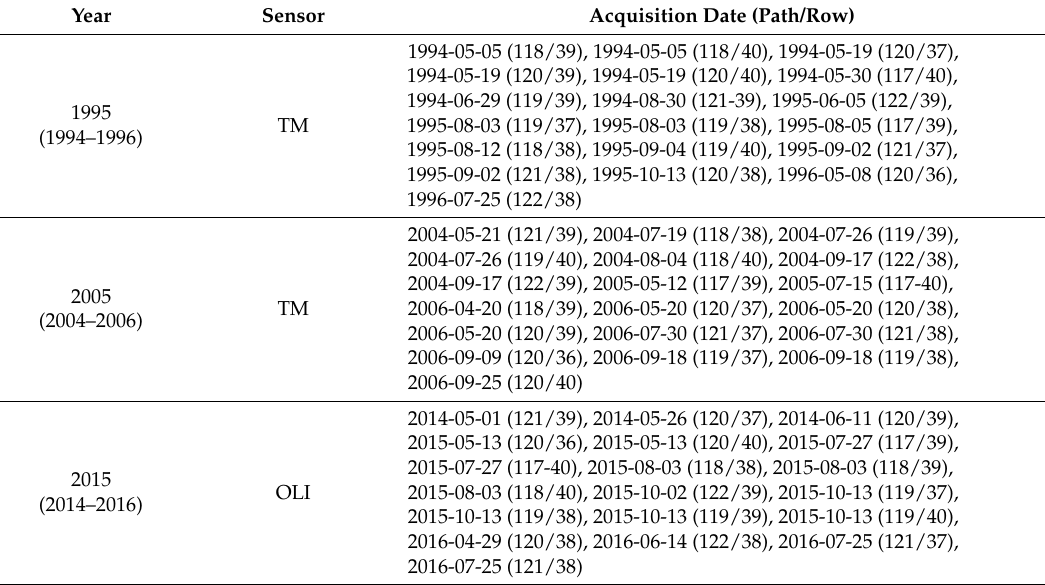
Table 1. Landsat image data used in the study. TM—Thematic Mapper; OLI—Operational Land